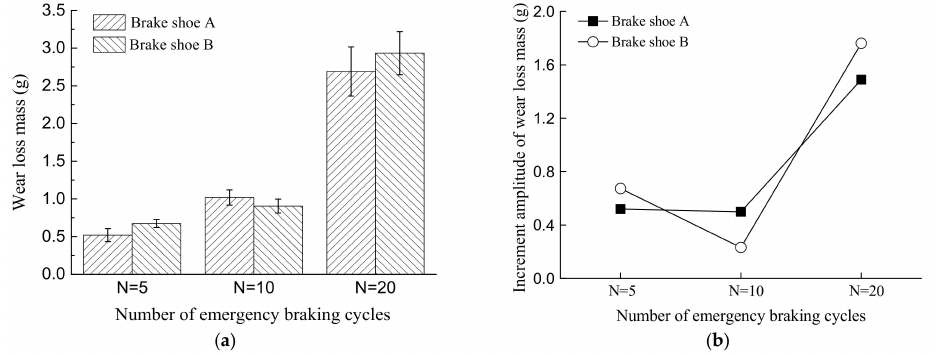
Figure 17. Wear loss masses and their increment amplitudes in brake shoes with different numbers of emergency braking cycles. ( a ) Wear loss mass ( b ) increment amplitude of wear loss